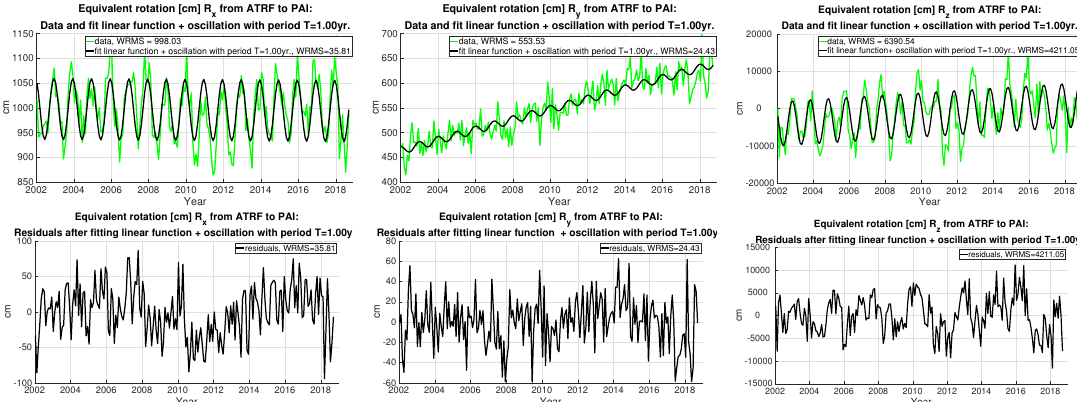
Figure 2. The results derived from the RL06 CSR Stokes coefficients with monthly resolution: ( top ) equivalent rotations [cm] R x , R y , and R z from ATRF to PAI frame (in green, from left to right) and fit linear functions plus annual oscillations (in black); and ( bottom ) the residuals are also given in [cm]. Table 2. The results derived from the RL06 CSR Stokes coefficients with monthly resolution.WRMS after fitting a linear function and an annual oscillation to each, biases, drifts, and annual amplitudes of the equivalent rotations R x , R y , and R z from ATRF to PAI. Units [cm] and [cm/year], time origin 2000.0, null phase at the origin. WRMS